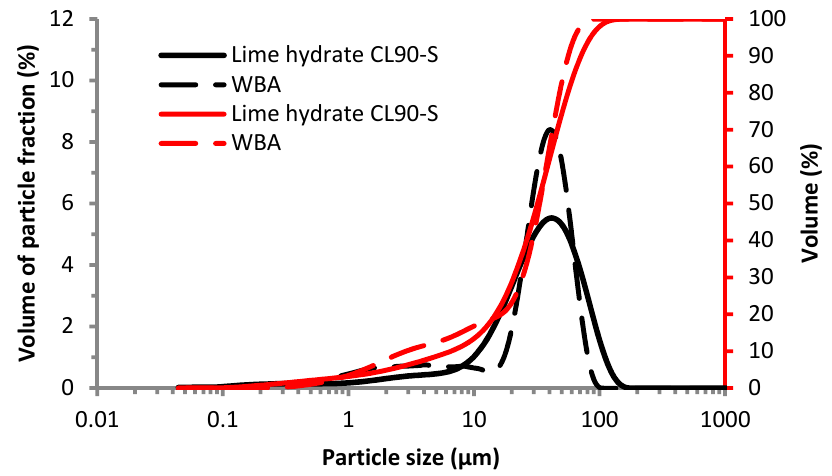
Figure 4. Particle size distribution of WBA and LH: incremental and distribution curves.